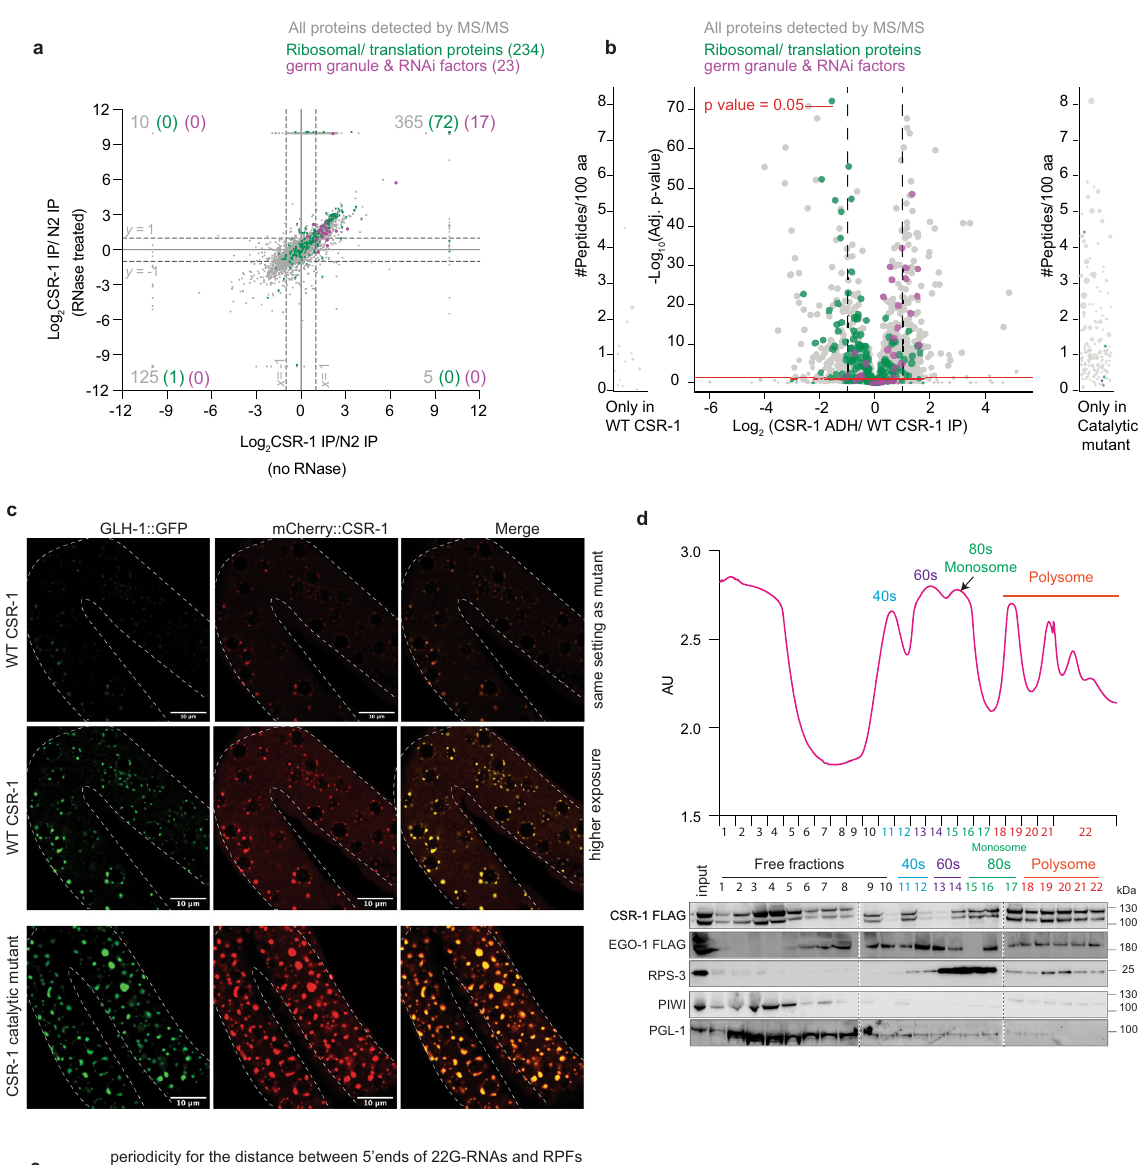
periodicity for the distance between 5’ends of 22G-RNAs